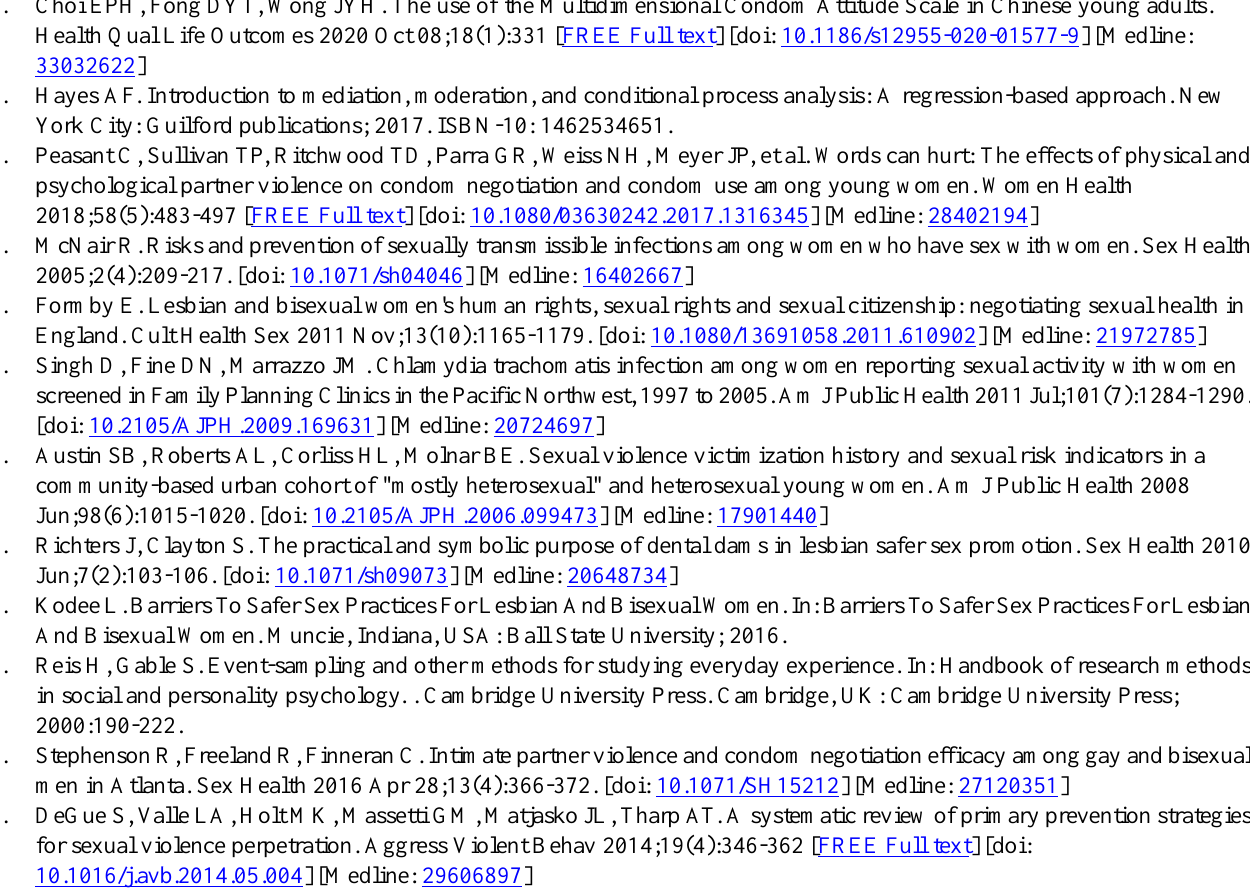
ICBI: interactive computer-based